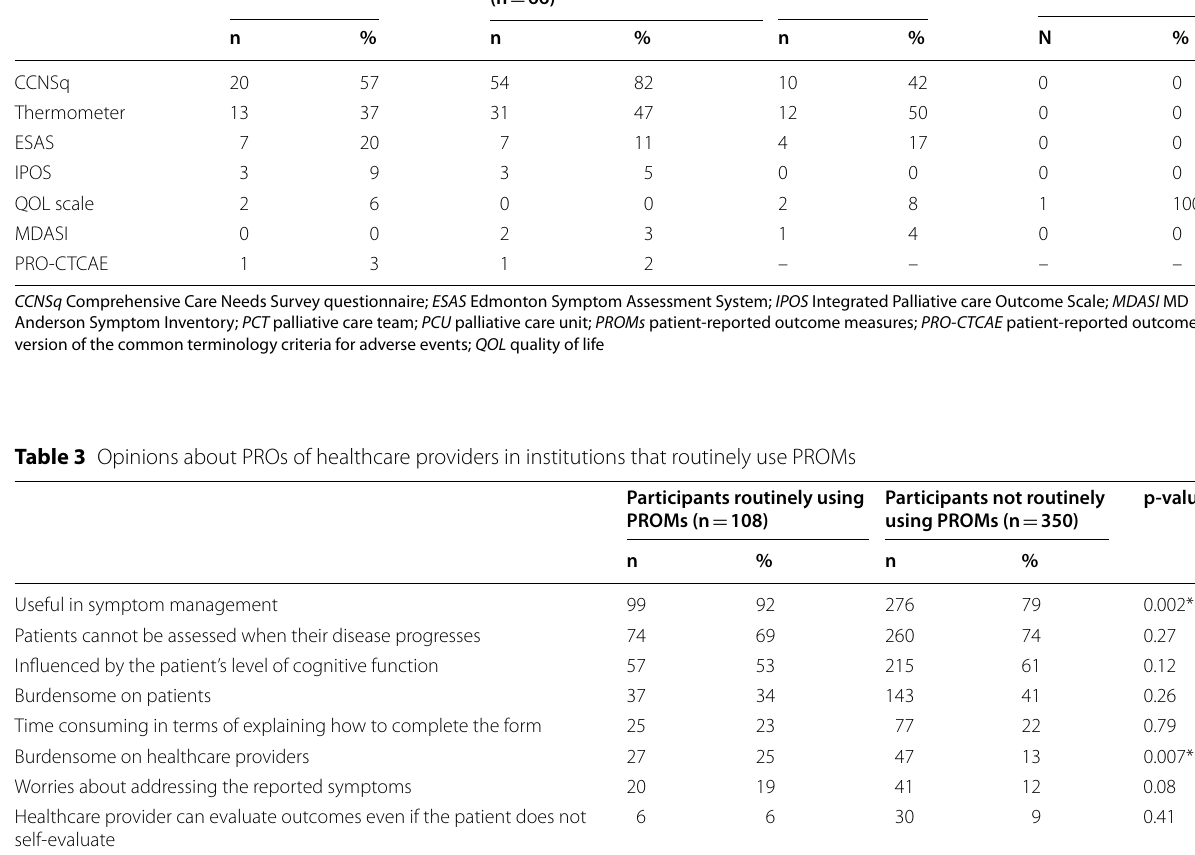
PROs patient-reported outcomes, PROMs patient-reported outcome